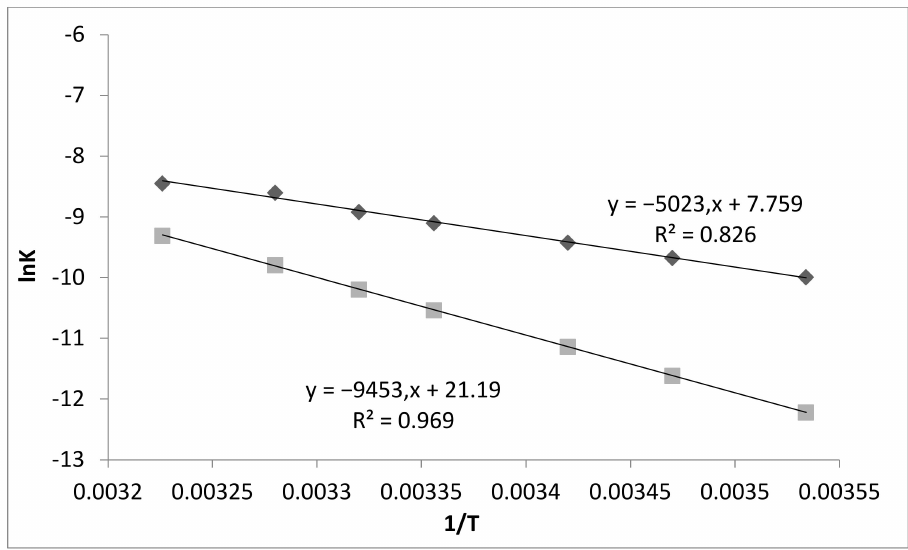
Figure 6. Dependence of the logarithms of the forward and reverse reaction rate constants on inverse